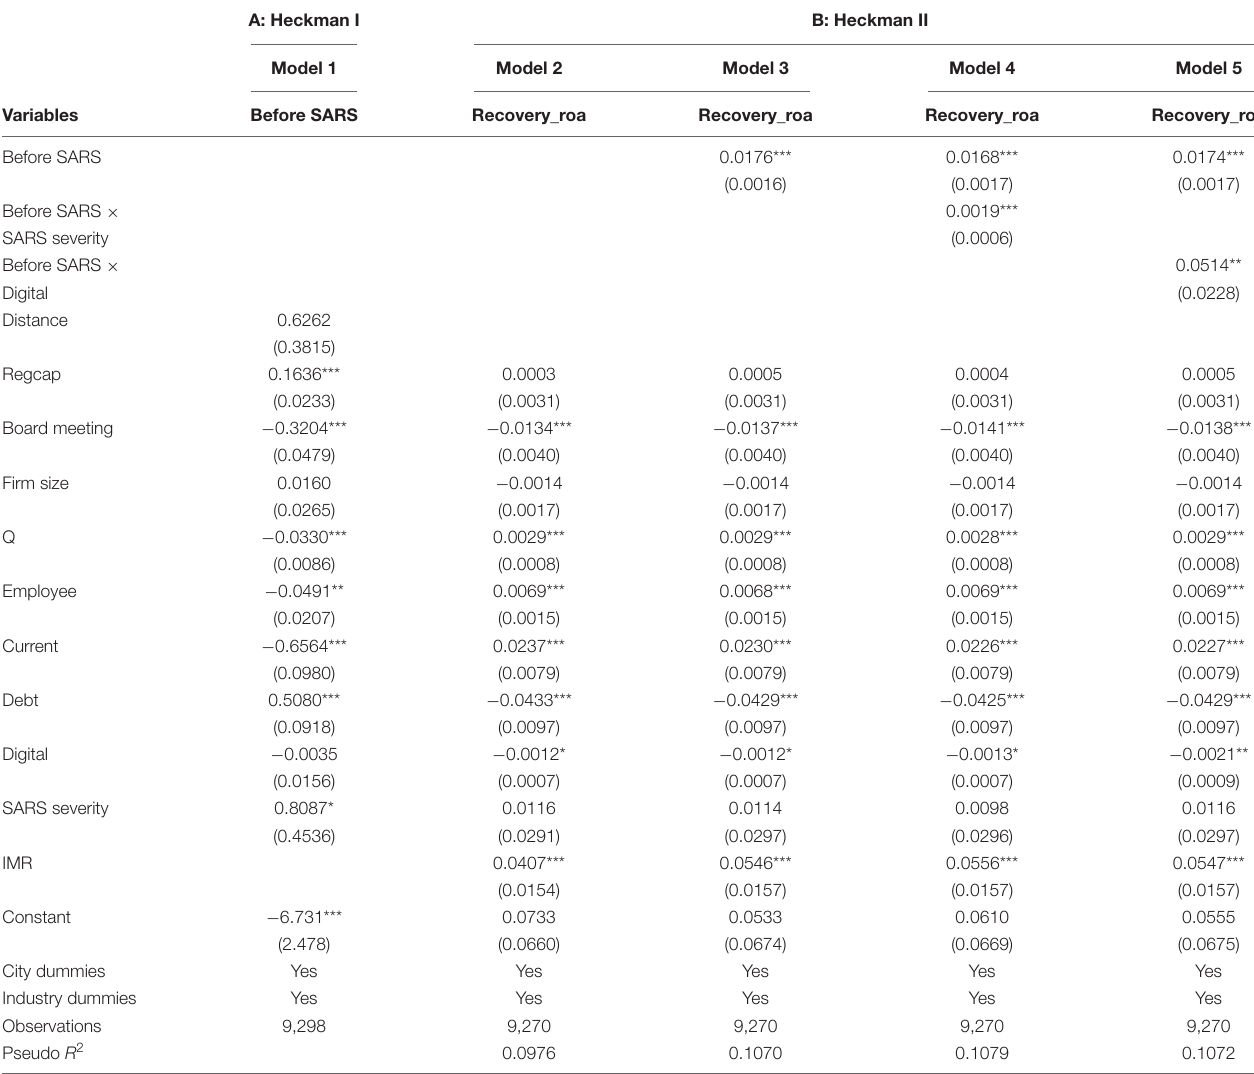
TABLE 5 | Results from the Heckman two-stage